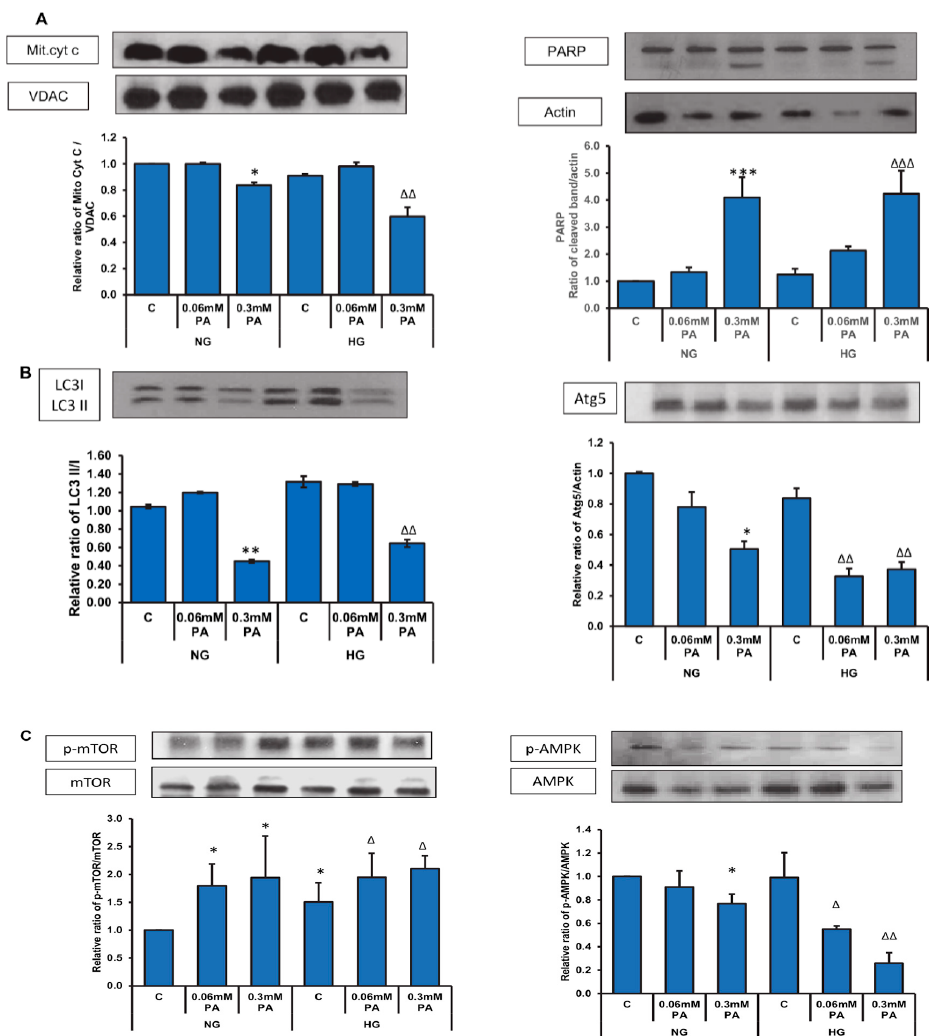
Figure 7. High glucose/high palmitic acid treatment-induced alterations in the expression of apoptotic, autophagy, and signaling proteins. Total extracts (30 µg protein) or mitochondrial extracts (10 µg) from control and treated cells were separated on 12% SDS-PAGE and transferred onto nitrocellulose paper by Western blotting. Mitochondrial cytochrome c (Mit. cyt c) and PARP ( A ), LC3 and Atg5 ( B ), and mTOR and AMPK ( C ) proteins were detected using specific antibodies against these proteins. Beta-actin and VDAC were used as loading controls for post-mitochondrial and mitochondrial extracts, respectively. The quantitation of the protein bands is expressed as relative ratios normalized against the loading control or other specific proteins as appropriate, and histograms are expressed as mean +/ − S.E.M of three experiments. The blots shown are representative of three experiments. Asterisks indicate significant difference (* p ≤ 0.05, ** p ≤ 0.01, *** p ≤ 0.001) relative to untreated control cells under normal glucose condition (NG-C), ( Δ p ≤ 0.05, ΔΔ p ≤ 0.01, ΔΔΔ p ≤ 0.001) relative to untreated control cells under high glucose condition (HG-C).